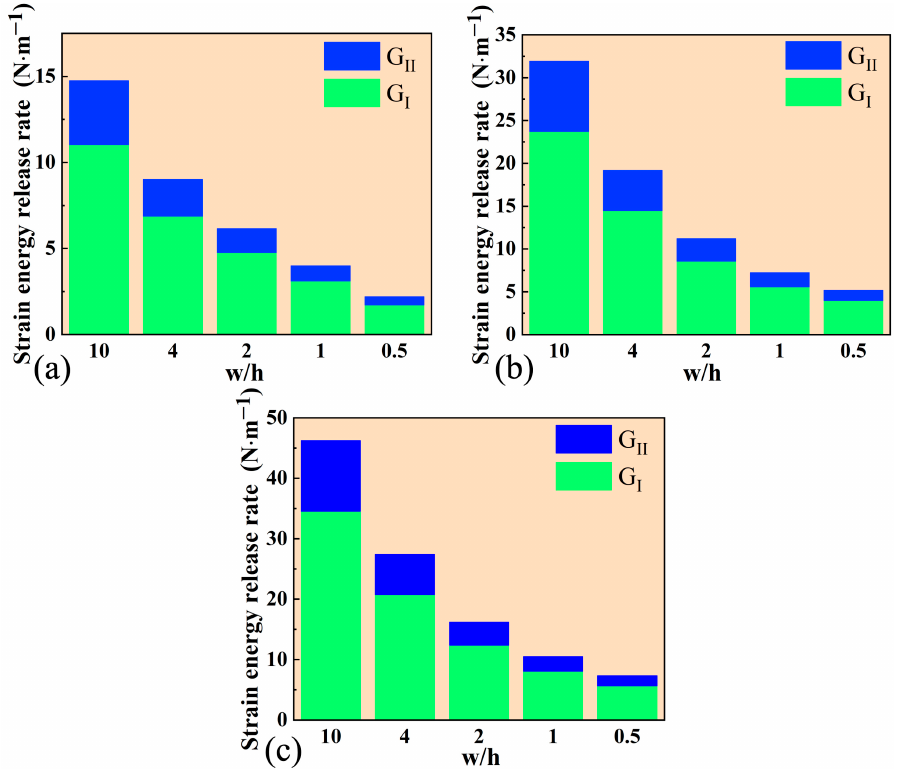
Figure 18. SERR changes after reducing stiffening: ( a ) 0.3, ( b ) 0.6, and ( c ) 0.9 mm thick TC.